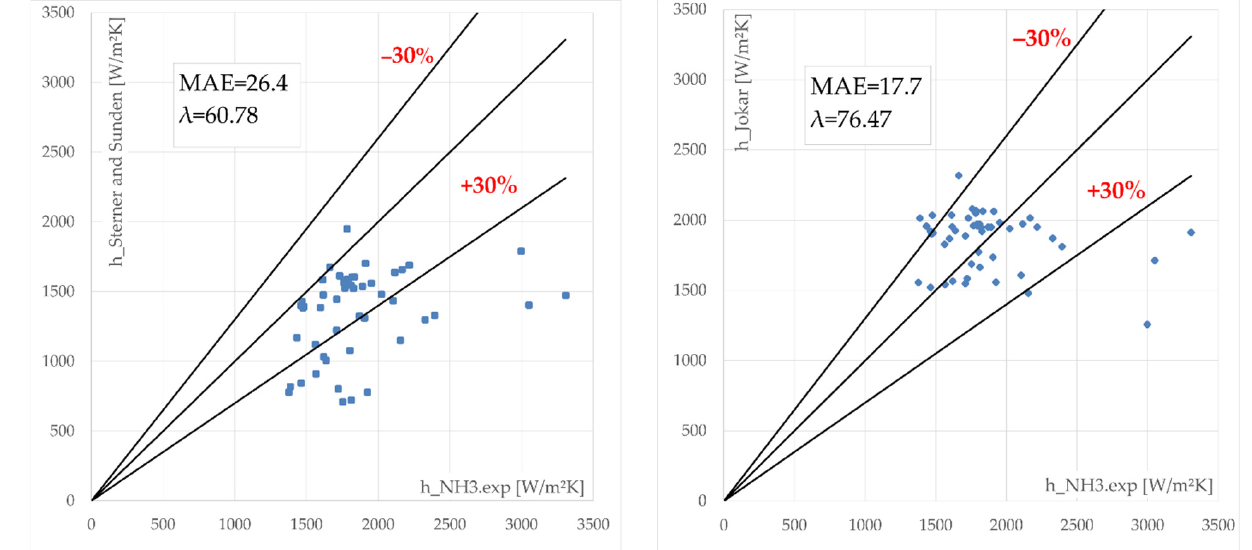
Figure 7. Calculated ammonia boiling coefficients (Shah et al., Sterner and Taborek, Sterner and Sunden and Jokar et al.) related to experimental values.